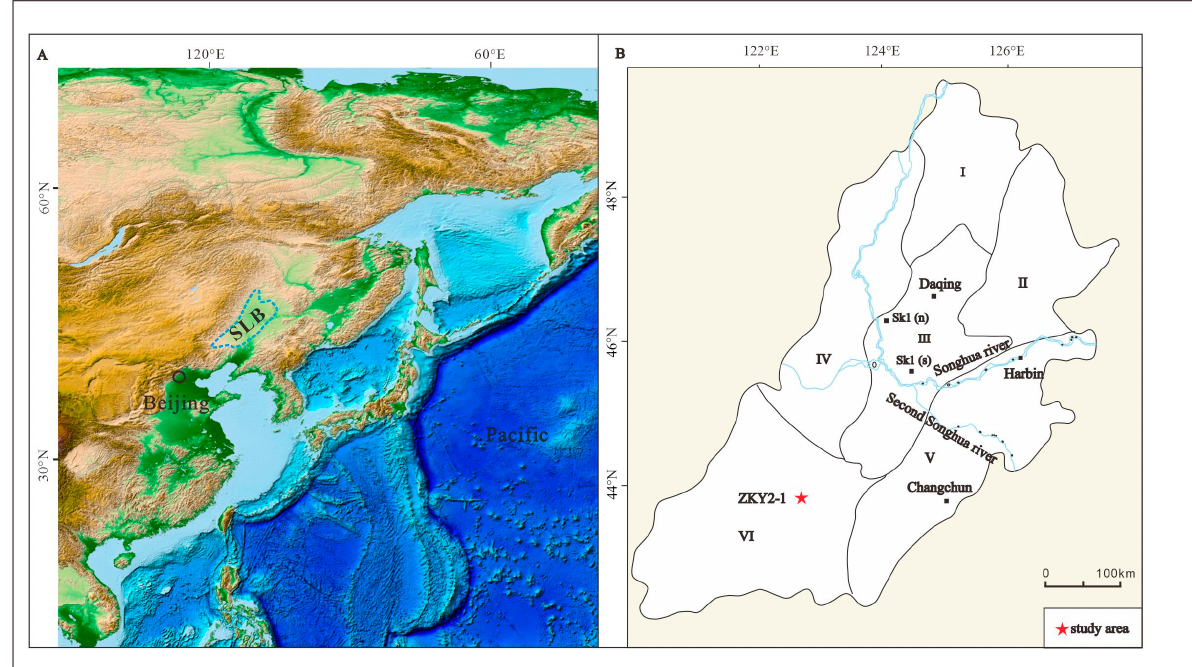
Figure 1. ( A ) Schematic diagram of Songliao Basin (SLB) and ( B ) the location of borehole ZKY2-1. I—North Plunge Zone; II—Northeast Uplift Zone; III—Central Deposition Zone; IV—West Slope Zone; V—Southeast Uplift Zone; VI—Southwest Uplift Zone.